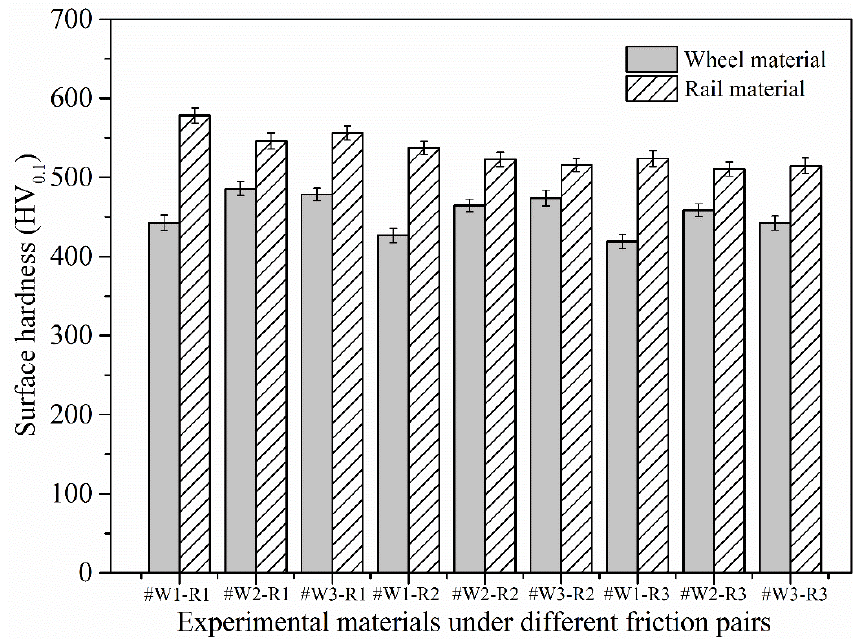
/ rail discs after the rolling-sliding